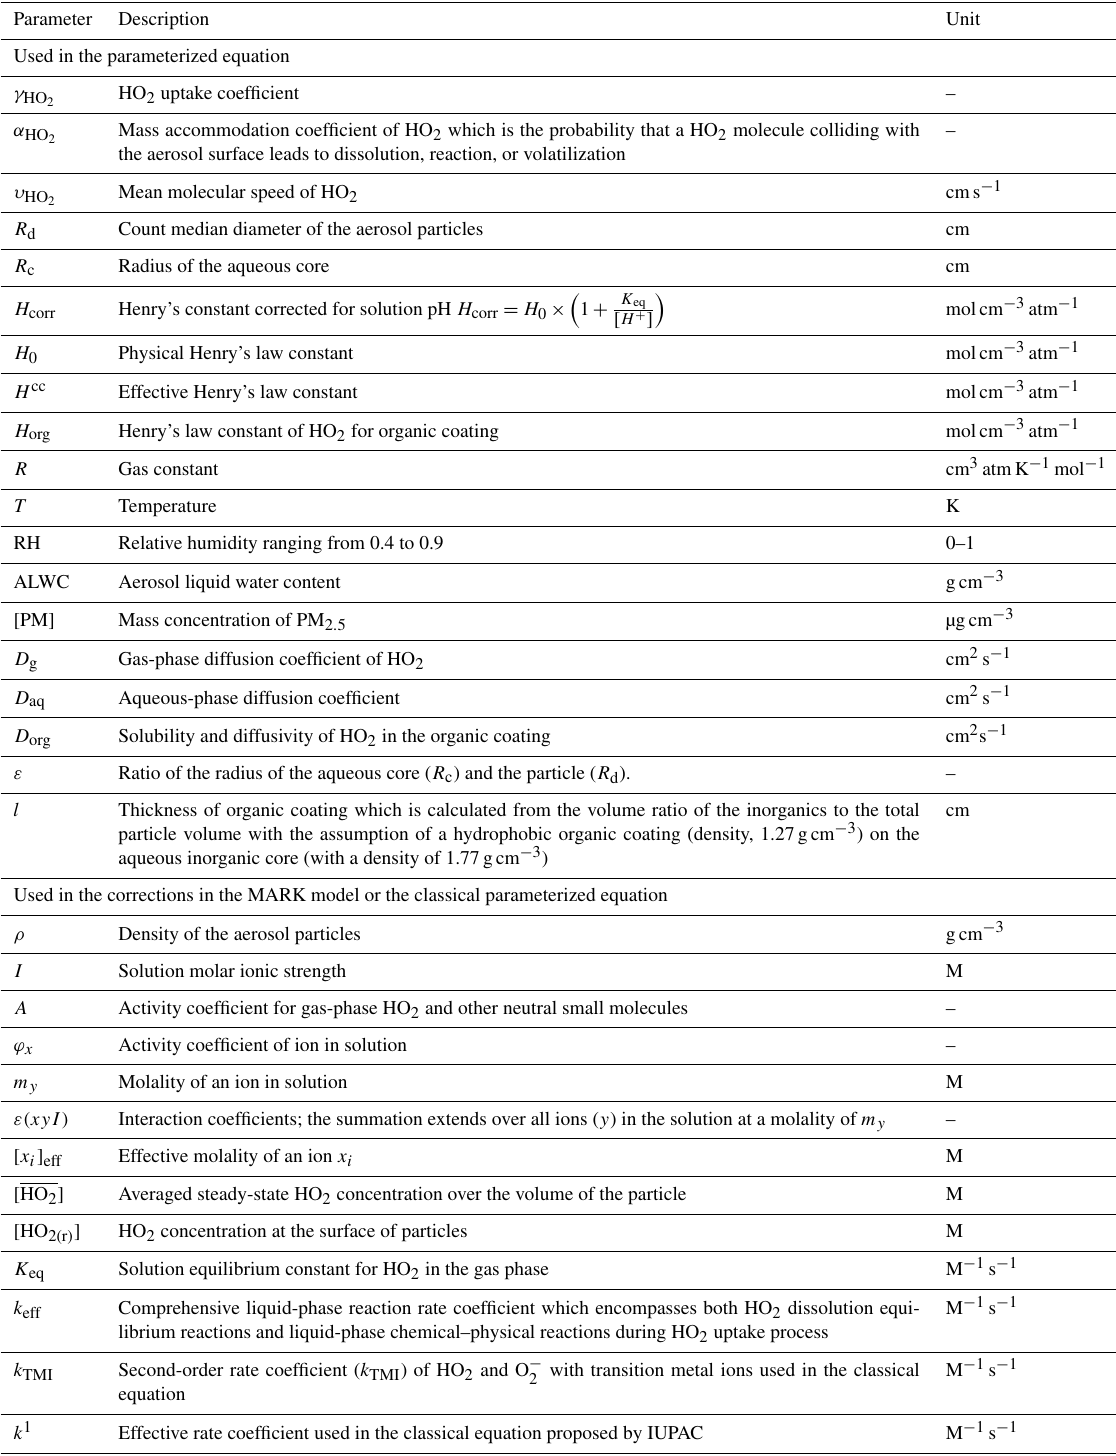
Table A1. Description and units of parameters used in the MARK model and the parameterized equations.